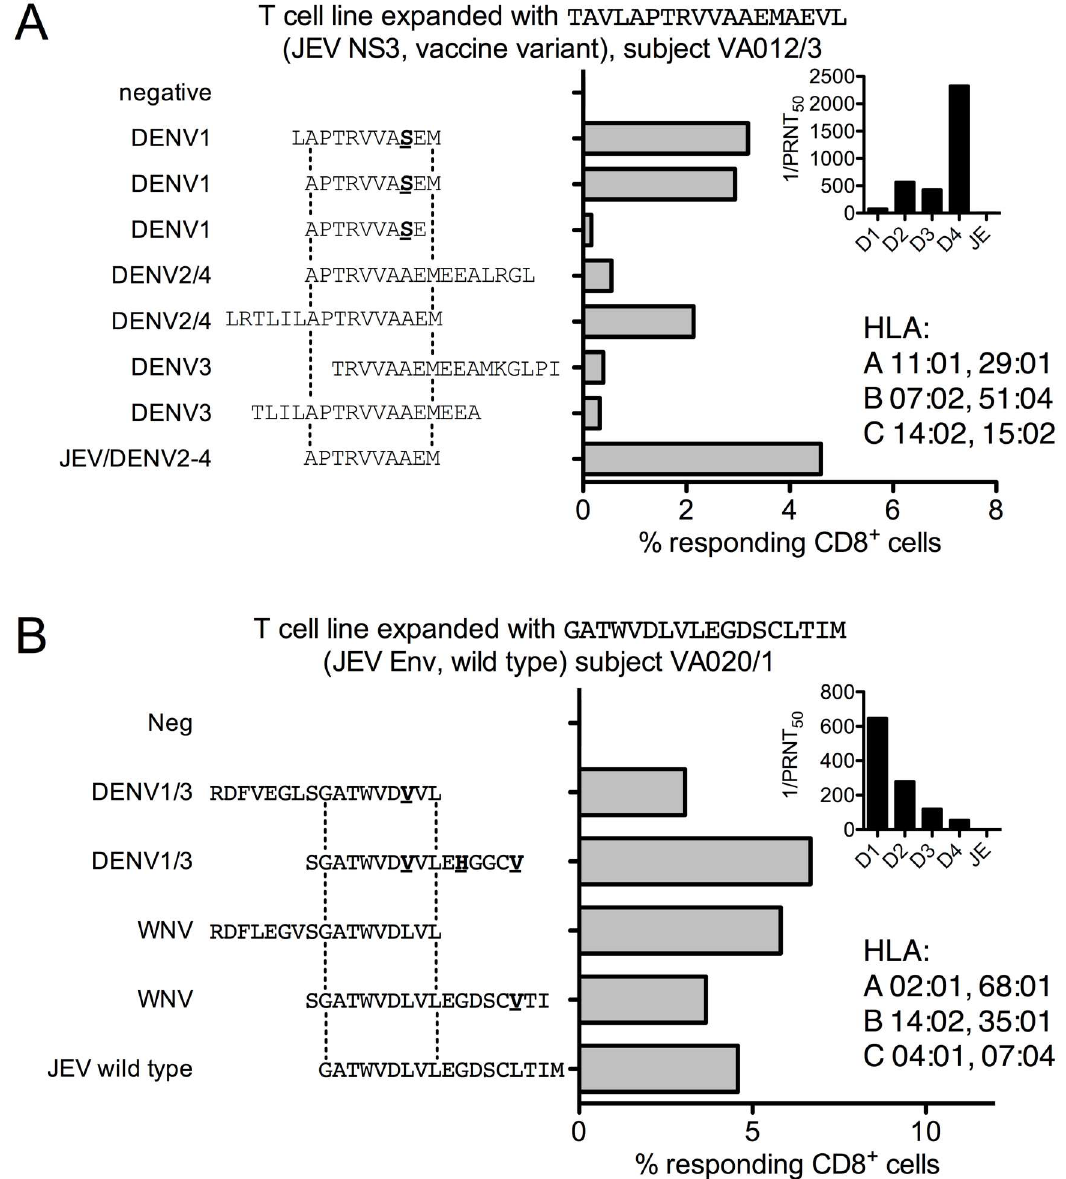
Fig 5. Cross-reactivity of anti-JEV IFN γ responses. (A) cross-reactive T cell responses to variant peptides from denguevirus (DENV) in participantVA012/3. Data are percent IFN γ + CD8 + T cells from a short-term T cell line expanded with JE vaccine NS3 peptideTAVLAPTRVVAAEMAEVL in an ICS assay to the peptidesindicated.Two earlier experiments expandingTCL to wild type and vaccine library peptides, which differ only in a Val/Ala substitution at position 17, outsidethe regionof epitopeconservation (dotted lines), gave the same result. Inset: ReciprocalPRNT 50 for all four DENV serotypes and JEV; HLA type. (B) cross-reactive T cell responsesto variant peptides from West Nile virus and DENV in participant VA020/1. Data are percent IFN γ + CD8 + T cells from a short-term T cell line expanded with JE vaccine E peptideGATWVDLVLEGDSCLTIM in an ICS assay to the peptides indicated.The dotted lines indicate the regionof epitopeconservation subsequently shown in another experiment (S4 Fig panel A). Inset: ReciprocalPRNT 50 for all four DENV serotypes and JEV; HLA type.